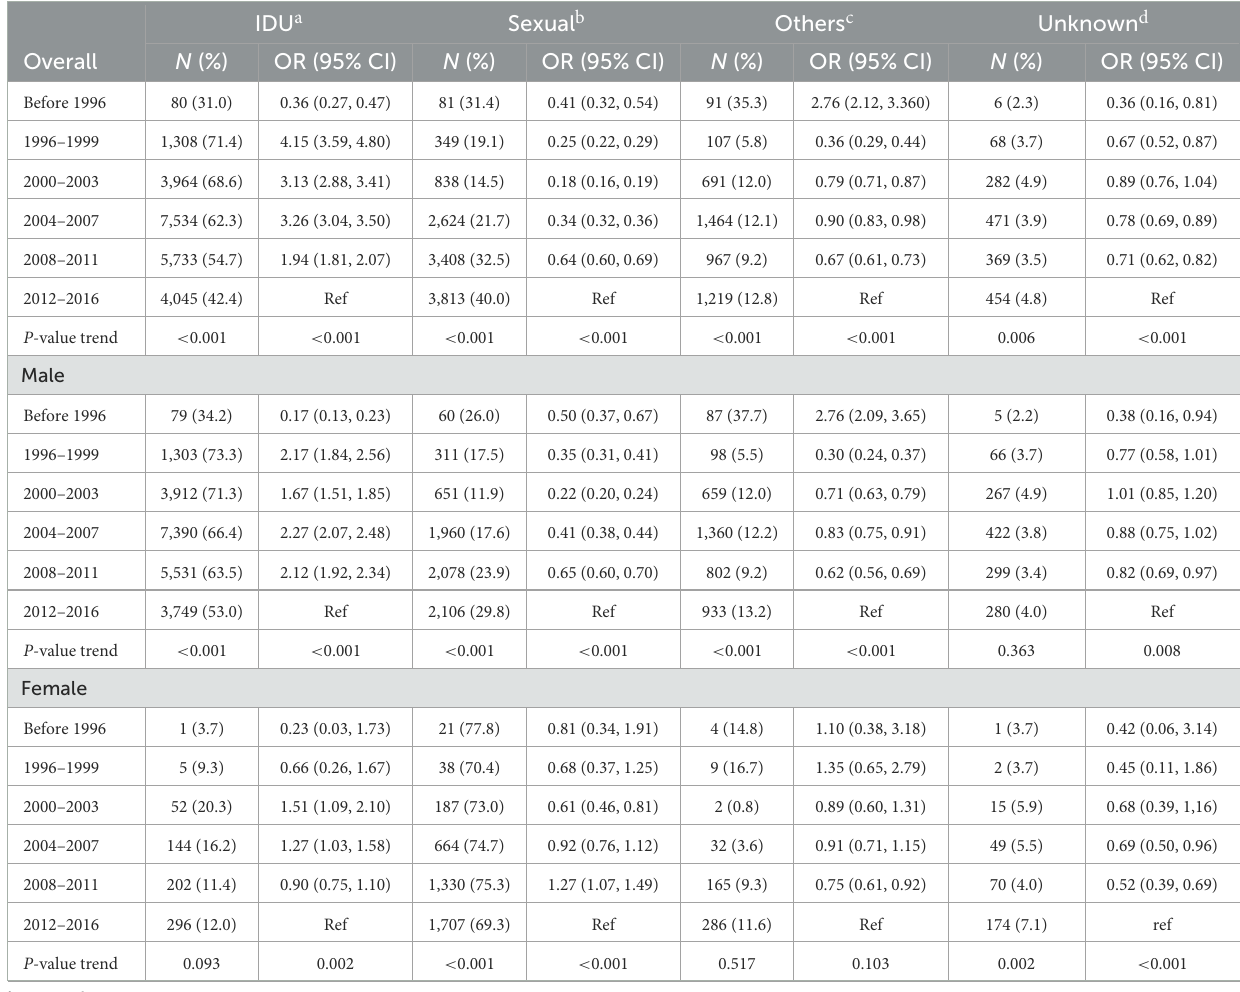
TABLE 2 Prevalence and trends of HIV risk categories among registered people with HIV in Iran ( N =